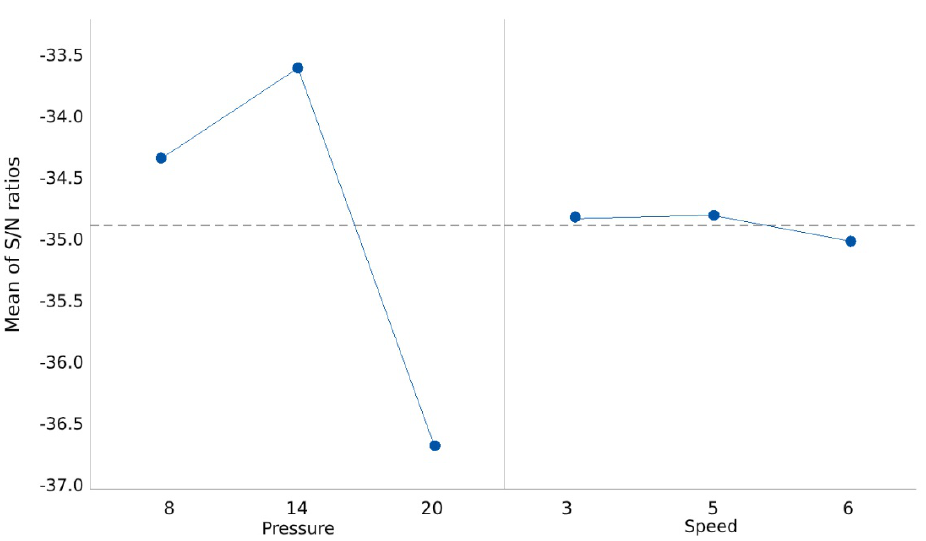
Figure 6. Main effects plot for S/N ratios. Figure 6. Main e ff ects plot for S / N ratios.